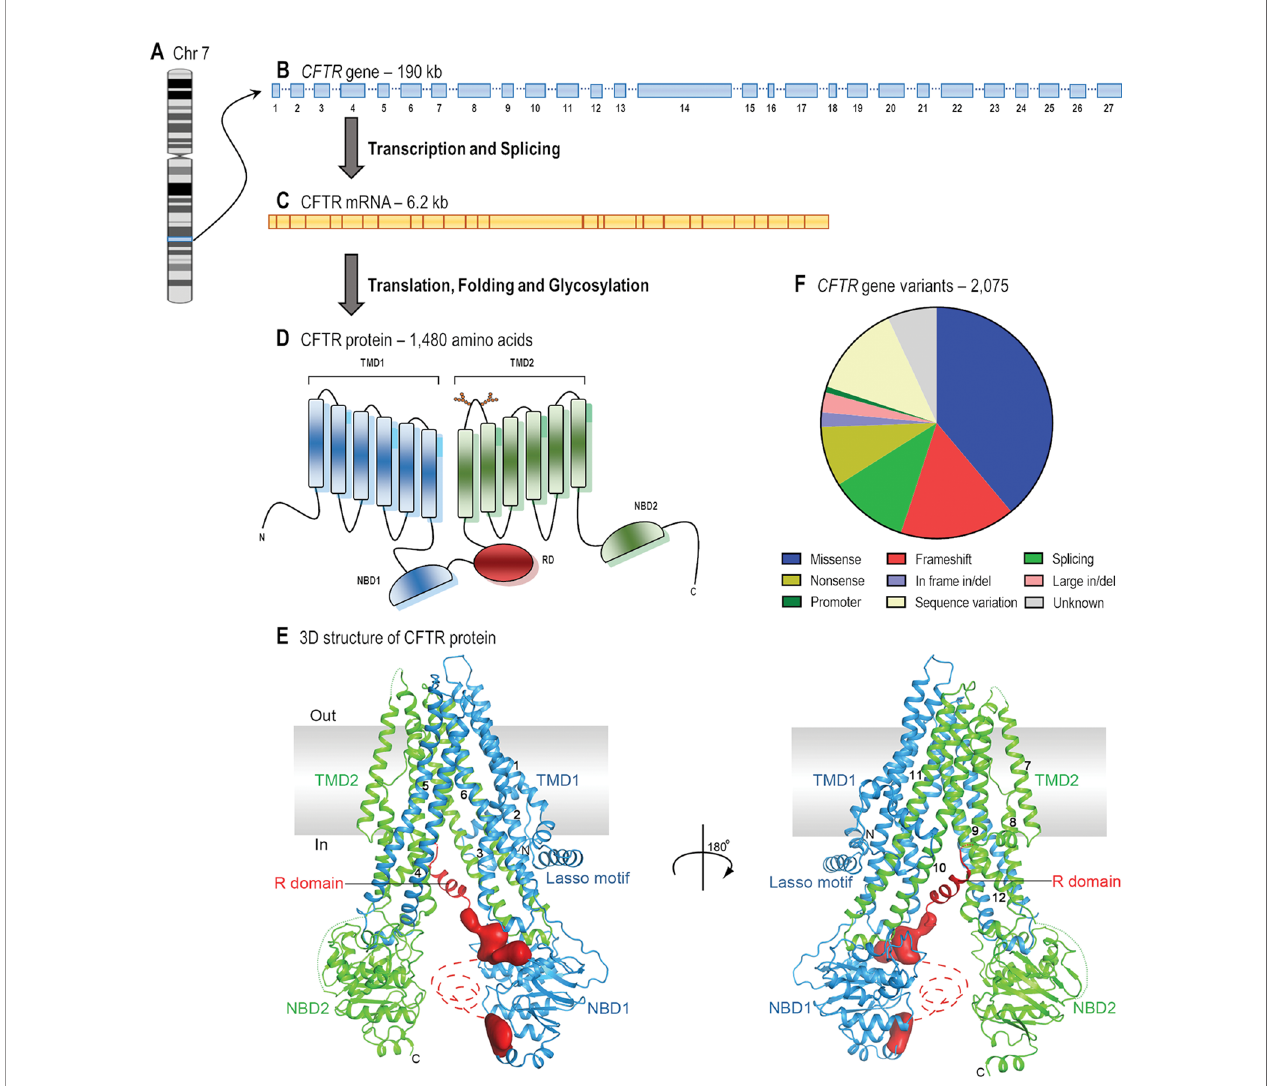
FIGURE 1 | From gene to protein structure. (A) CF transmembrane conductance regulator ( CFTR ) gene is located on the long arm of chromosome (Chr) 7. (B) The gene contains 27 exons and spans approximately 190 kb of human genomic DNA. (C) The mRNA is 6.2 kb long including the untranslated regions (adapted from Collins, 1992). (D) The protein forms a chloride/bicarbonate channel composed of fi ve domains: two transmembrane domains (TMD1 and TMD2), two nucleotide- binding domains (NBD1 and NBD2) and a regulatory domain (RD) (adapted from Lopes-Pacheco, 2016). (E) The overall structure of human CFTR in the dephosphorylated, ATP-free conformation (adapted from Liu et al., 2017 with permission from Prof. J. Chen). (F) The 2,075 CFTR gene variants that have so far been reported consist of missense (38.9%), frameshift (16.1%), splicing (11.1%), and nonsense (8.4%) mutations; in-frame (2.1%) and large (2.8%) deletions or insertions; promoter mutations (0.9%); and possibly non-pathogenic variants (13.0%) (adapted from CFTR1